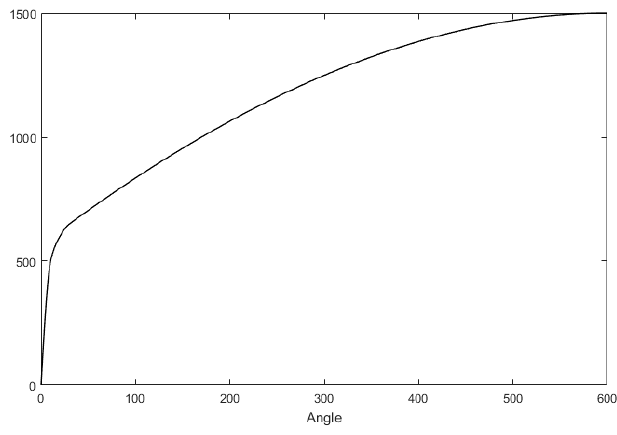
Figure 6. Relationship between the RTC torque and the steering wheel angle.